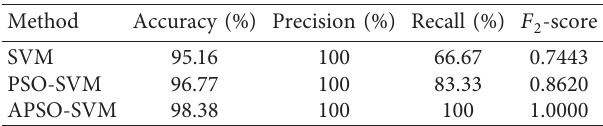
Figure 4: Test data set prediction results of three models. (a) Prediction results by SVM model. (b) Prediction results by PSO-SVM model. (c) Prediction results by APSO-SVM model. (d) Comparison of prediction results. Table 5: Index comparison results of the three